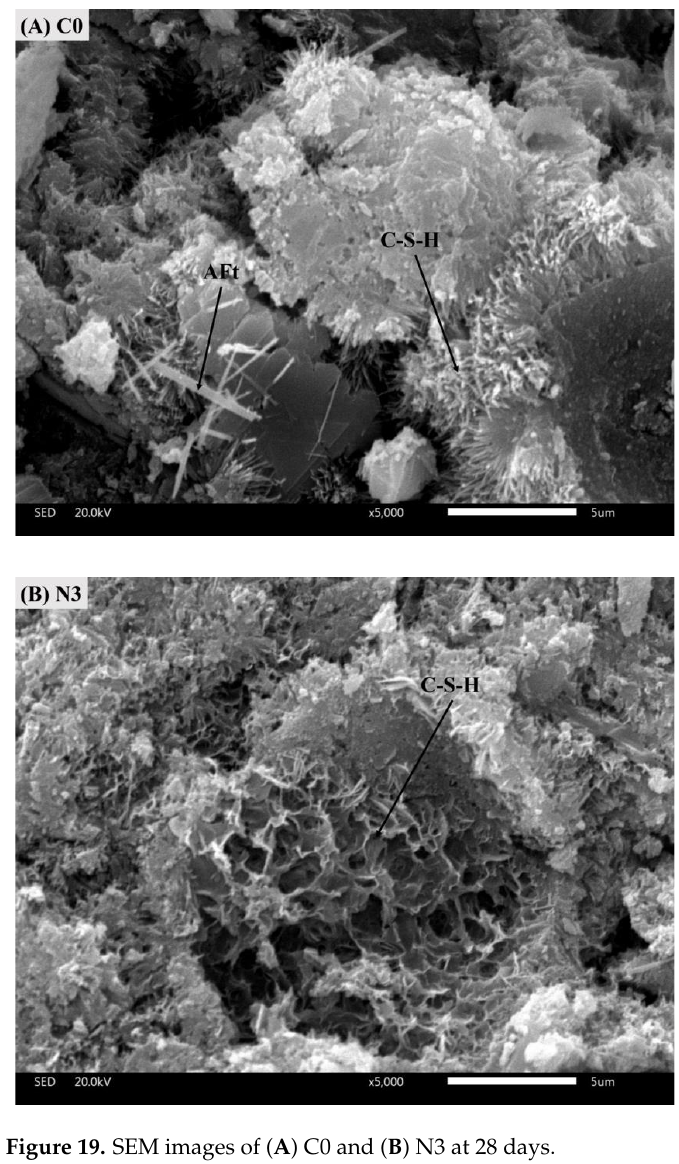
Figure 19. SEM images of ( A ) C0 and ( B ) N3 at 28